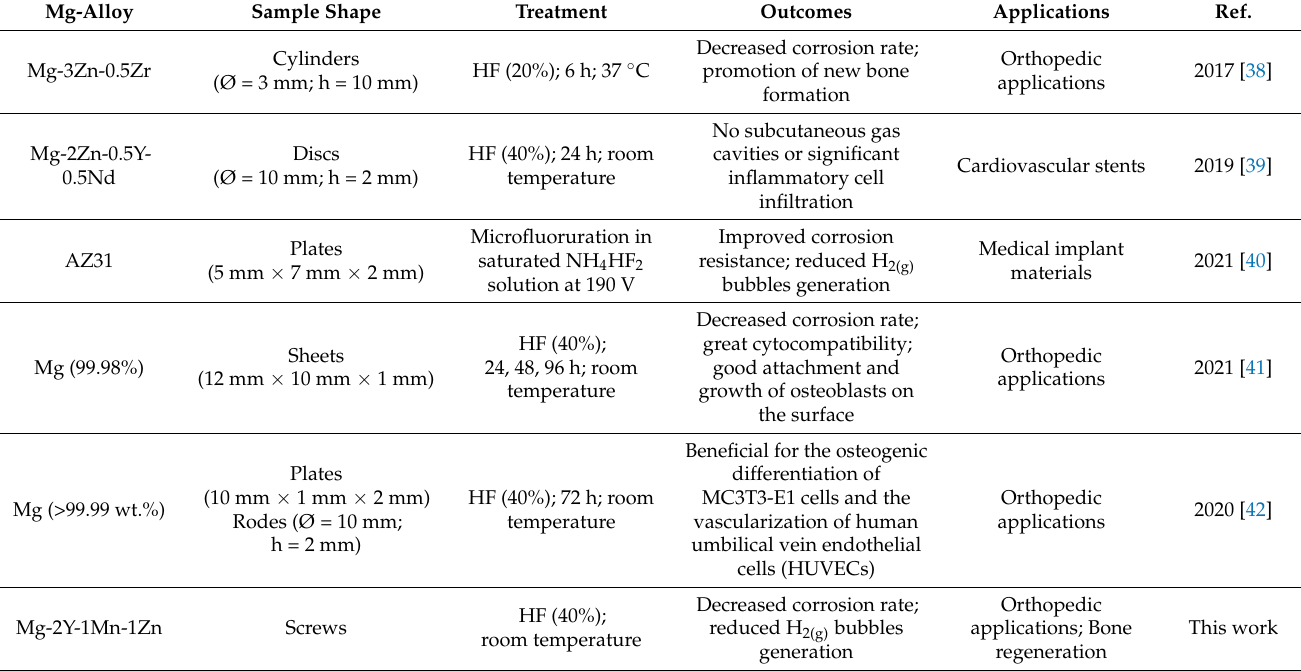
Table 1. Recent studies on MgF 2 coating on Mg-based